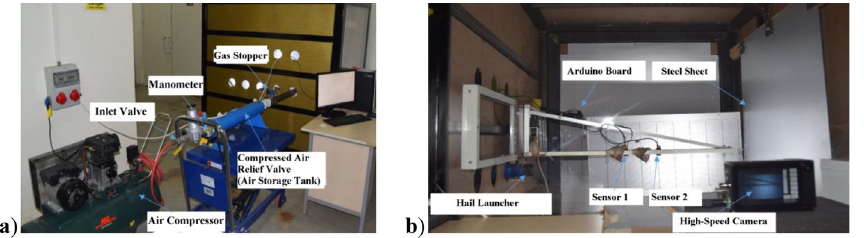
Figure 2. Setup using ( a ) a hail cannon and ( b ) a camera and velocity probes.